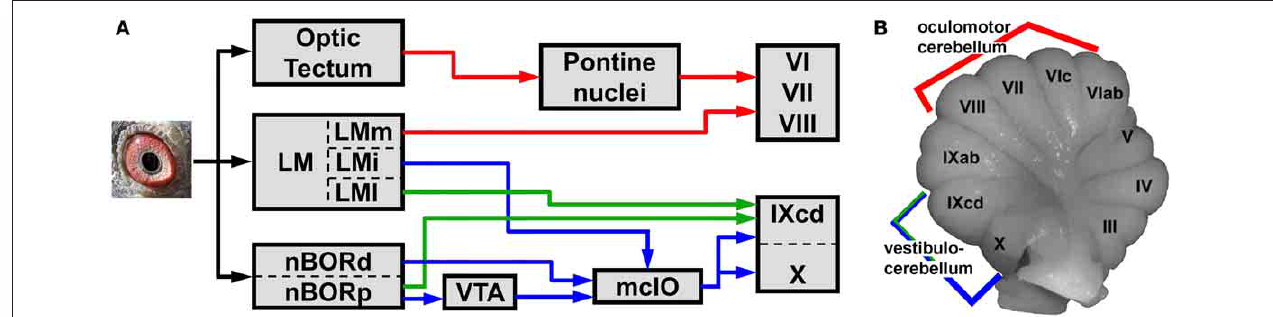
FIGURE 1 | A reduced schematic, showing the visual pathways (A) to the cerebellum (B) in birds. The cerebellum is divided into folia, numbered I–X from anterior to posterior (Larsell, 1967). Folia IXcd and X comprise the vestibulocerebellum, which receives optic flow input from the nucleus of the basal optic root (nBOR) and lentiformis mesencephali (LM) via a climbing fiber pathway through the medial column of the inferior olive (mcIO) (blue pathway) (Arends and Voogd, 1989; Lau et al., 1998). The LM and nBOR also project directly to folium IXcd as mossy